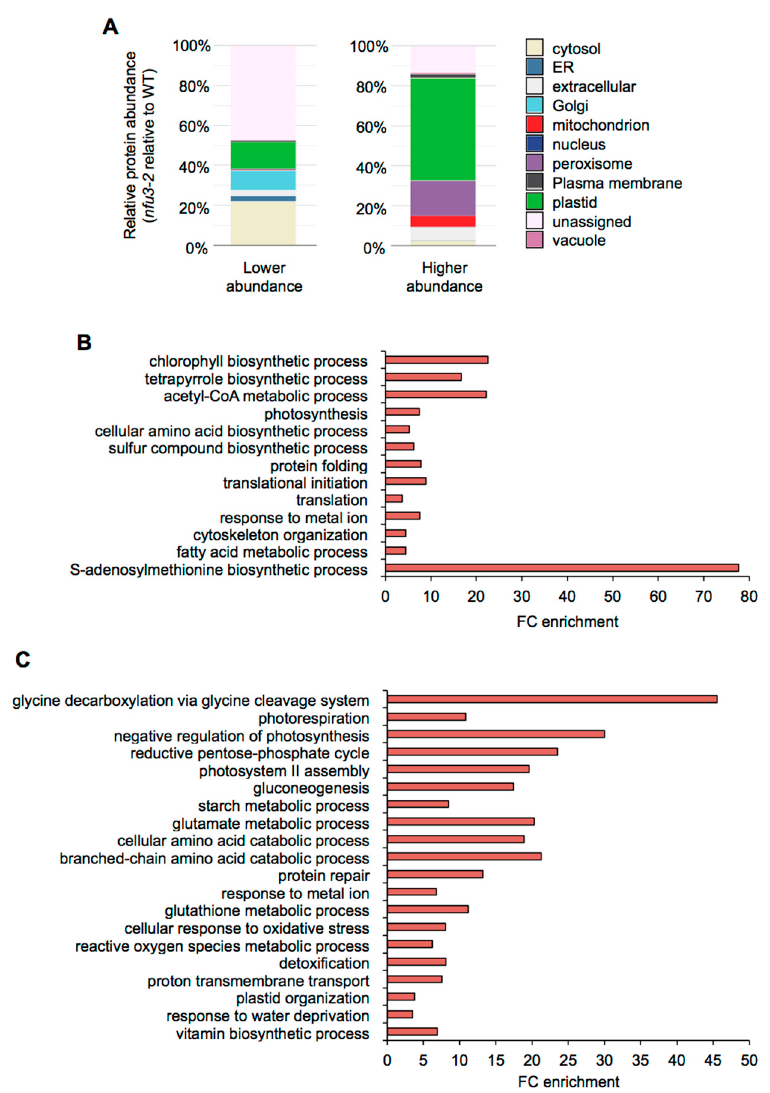
Figure 3. Subcellular localization and gene ontology analysis of proteins whose abundance is modified in the Arabidopsis thaliana nfu3-2 mutant compared to the wild type. Protein localization was analyzed in silico using the multiple marker abundance profiling method of the SUBA4 bioinformatic platform (http: // suba.live / ) ( A ). Gene ontology (GO) term enrichment analysis was conducted using the PANTHER gene ontology platform (http: // go.pantherdb.org) considering proteins whose abundance was significantly decreased ( B ) or increased ( C ) in nfu3-2 mutant when compared to the wild type. Significant GO term enrichment was determined using Fisher exact test with Bonferroni